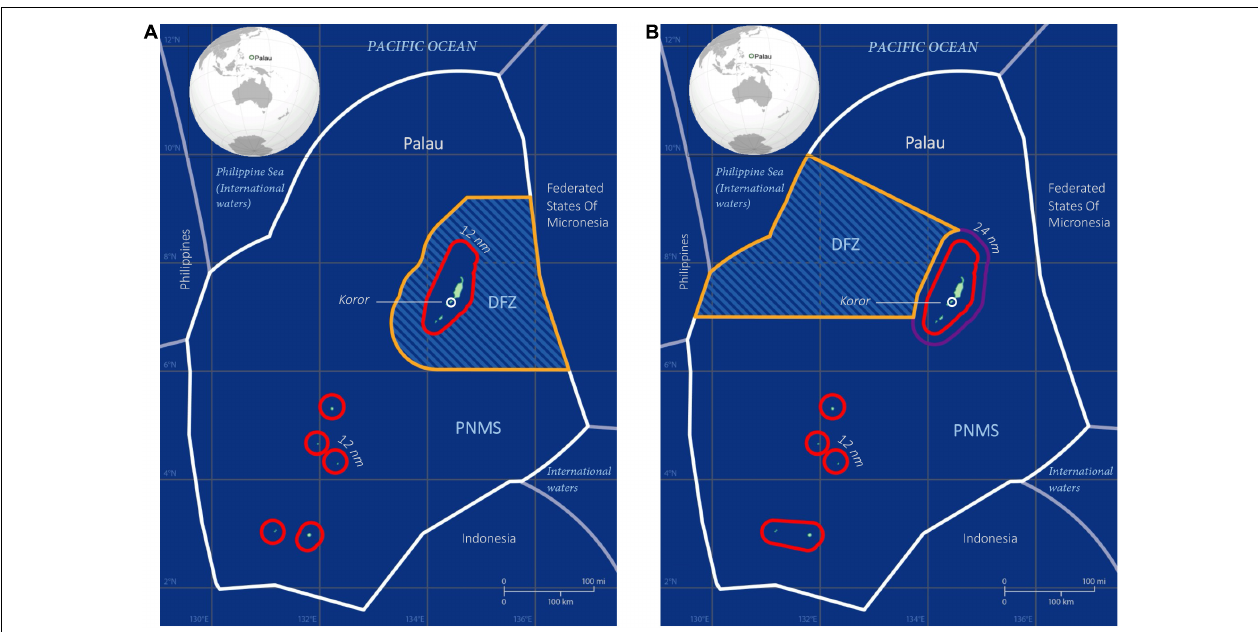
FIGURE 1 | Map of the Palau National Marine Sanctuary (PNMS) and Domestic Fishing Zone (DFZ), (A) as designated in the original PNMS Act 2015 and (B) as revised in the 2019 amendment to the PNMS Act, and implemented in January 2020. Red lines represent the 12 nm territorial seas boundary. Only pole-and-line and small personal vessels are permitted to fish within the 24 nm contiguous zone boundary (purple) around the main island group, which belongs to the DFZ. The orange boundary line denotes that part of the DFZ where longline fishing is permitted. The PNMS extends from the 12 and 24 nm boundary, respectively, to the edge of the Exclusive Economic Zone (EEZ) (white line). Malakal fishing port is situated near